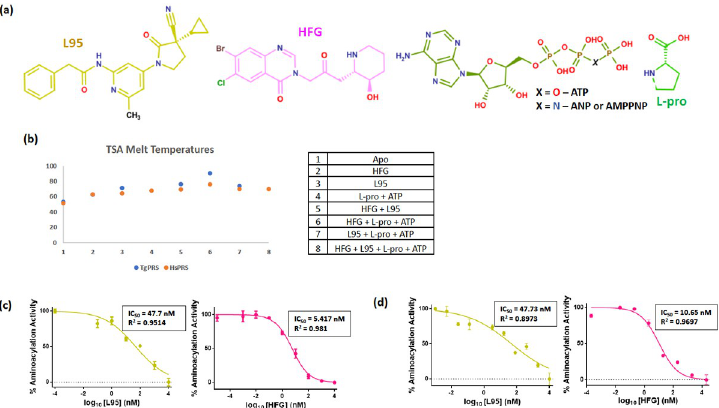
Fig 1. Biochemical binding and inhibition profiles of HFG and L95. (a) Chemical structures of L95, halofuginone (HFG), L-proline and ATP/ANP (Non hydrolysable ATP analog). (b) TSA melt temperatures of Tg PRS and Hs PRS (at 1 μ M) in the presence of inhibitors alone or along with substrate. (c) Tg PRS aminoacylation activity inhibition assays in the presence of HFG and L95. For these the concentration for compounds ranged from 50 to 0.005 μ M. (d) Hs PRS aminoacylation activity inhibition assays in the presence of HFG and L95. For these the concentration for compounds ranged from 50 to 0.005 μ M.